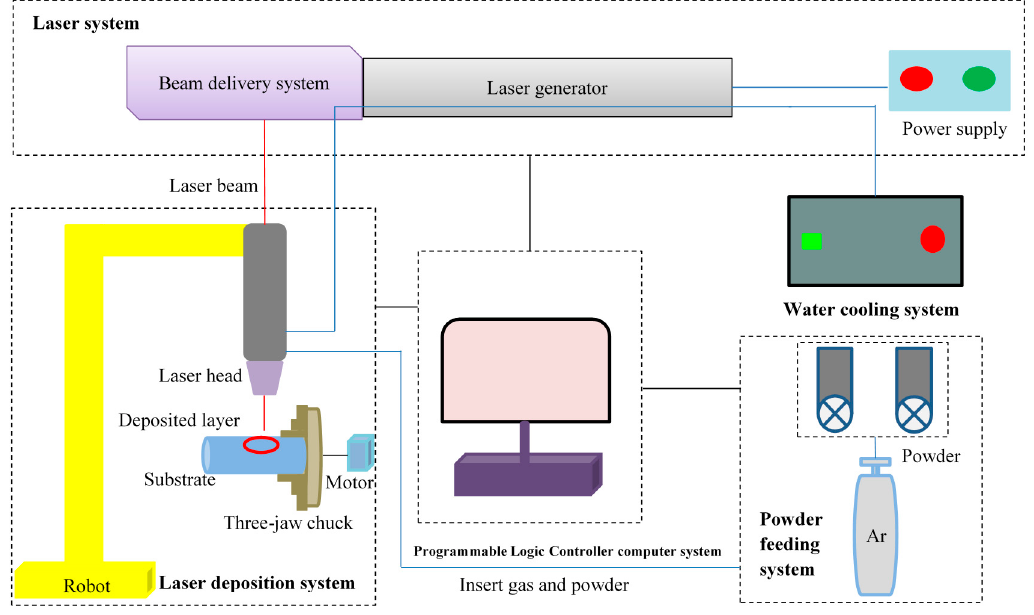
Figure 2. Schematic illustration of a laser cladding system.